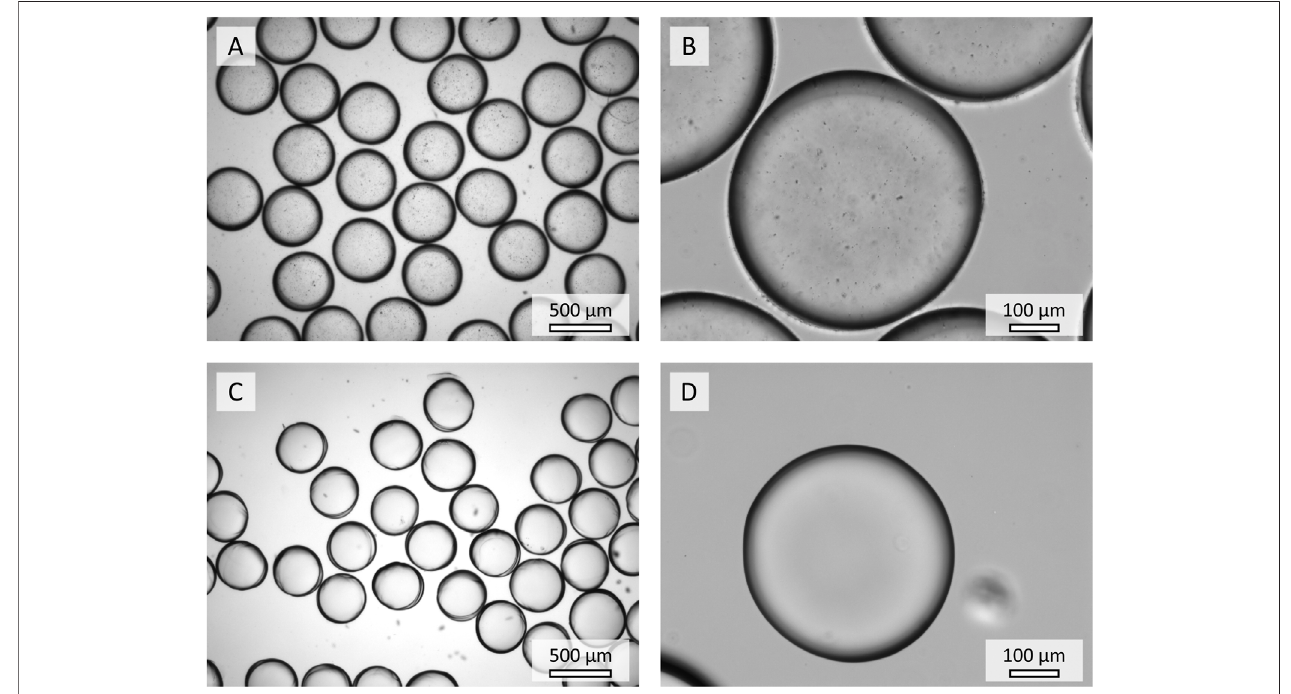
FIGURE 5 | Microscopic images of the hydrogel microparticles containing ENPs (A,B) and unbound enzyme (C,D) .